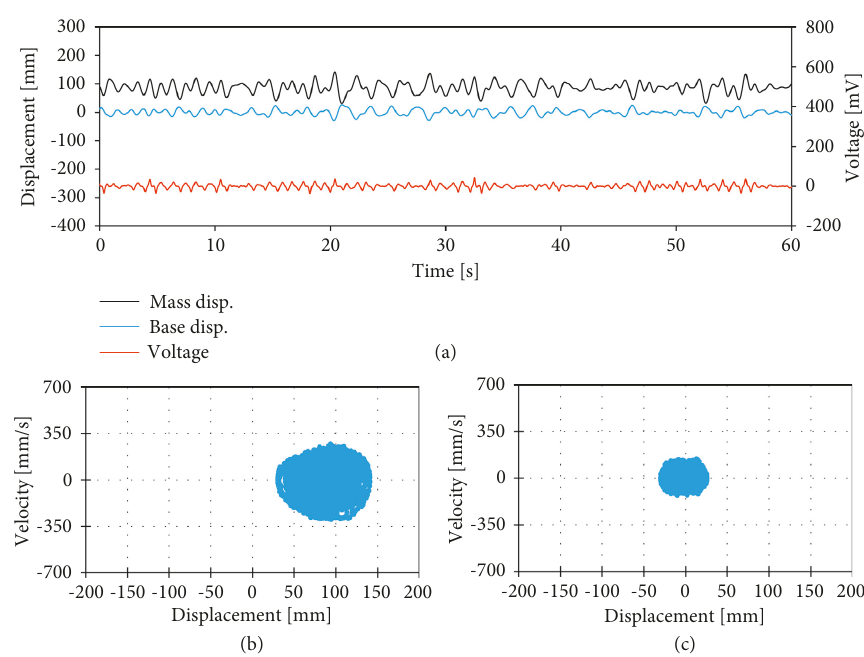
Figure 9: Measured results for response vibration displacement and vibration power generation for vibration with a periodic signal at 1.50Hz. (a) Response vibration displacement results. (b) Diagram of displacement vs. velocity of vibration for the mass block. (c) Diagram of displacement vs. velocity of vibration for the support.